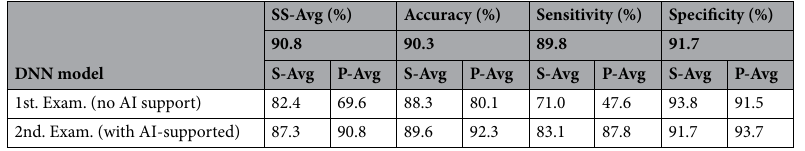
Table 3. Comparison of parameters between the first and second (i.e., AI-supported) diagnostic examinations. S-Avg: Average results for radiological specialists. P-Avg: Average results for radiological practitioners. DNN model results (sarcoma likelihood and sequences for each patient) were provided to the radiologists for the second examination. Remarkably, all parameters were superior among radiological practitioners than among radiological specialists, although the difference was not significant ( p >